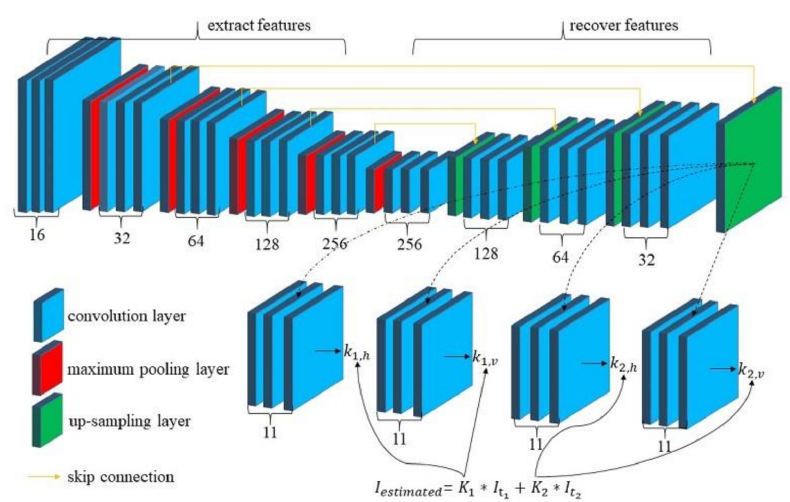
Figure 3. Overview of our separable convolution network